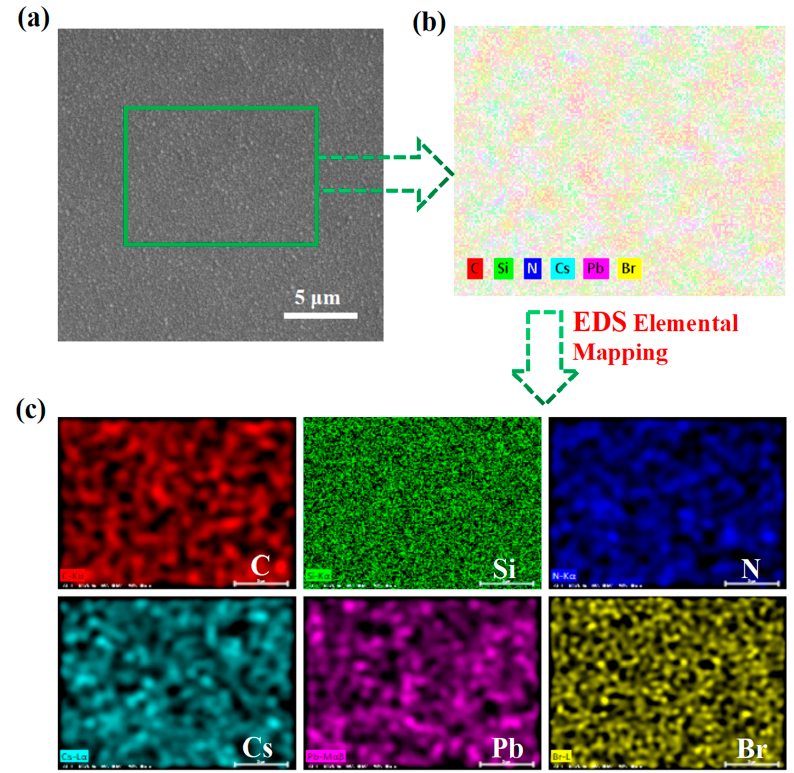
Figure 1. ( a ) SEM image of the CsPbBr 3 QDs/a-SiC x N y :H nanocomposite thin film. ( b ) Elemental mapping of the CsPbBr 3 /a-SiC x N y :H nanocomposite thin film recorded by EDS. ( c ) EDS elemental mapping of Cs, Pb, Br, Si, N, and C in the thin film, respectively. From Figure 2d, it can be observed that without the addition of ammonia, the lumi- nescence intensity of the CsPbBr 3 QDs encapsulated with a-SiC x :H was weaker than that of the uncoated CsPbBr 3 QDs. Additionally, the PL peak position of the SiC x -encapsulated CsPbBr 3 QDs exhibited a redshift, and the full width at half maxima (FWHM) of the PL were narrower as compared to the uncoated CsPbBr 3 QDs. This phenomenon could pos- sibly be attributed to the self-absorption effect of the a-SiC x :H coating on the CsPbBr 3 QDs. To further test this hypothesis, the transmission spectra of a-SiC x N y :H films prepared us- ing different NH 3 flows were measured, as depicted in Figure 3. As the NH 3 flow rate decreased from 15 SCCM to 0 SCCM, the absorption edge of the transmission spectrum progressively shifted towards the longer wavelength region. This suggests that the optical band gap of the film gradually decreased with the decrease of NH 3 flow rate. According to the formula [24]: α d = − ln T, where T is the transmittance and d is the film thickness, the absorption coefficient α of the film can be obtained. Thus, the Eopt can be calculated according to the Tauc equation ( α h ν ) 1/2 = Β (h ν − Ε opt) [25], where α is the absorption coefficient and B is a constant. From the inset of Figure 3, it is evident that the E opt of the a-SiC x N y :H decreased from 5.20 to 2.55 eV when the NH 3 flow rate was decreased from 15